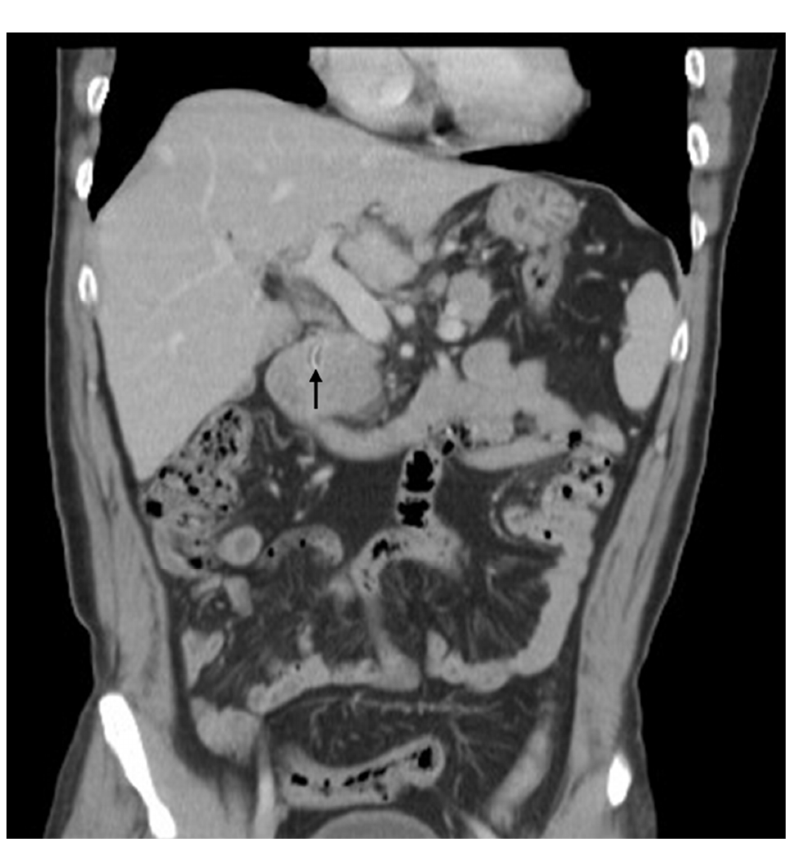
Figure 1. A computed tomography (CT) scan of the abdomen demonstrated abscess over the left lobe of the liver and a linear curve of high-density material within a mass. A 58-year-old man pre- sented at our hospital with right upper-quadrant pain and fever. He had undergone laparotomic cholecystectomy and choledochojejunostomy 28 years prior at another hospital. He had been healthy until 3 days before his admission, when his symptoms appeared. A computed tomography (CT) scan of the abdomen demonstrated abscess over the left lobe of the liver and a linear curve of high-density material within a mass (Figure 1; arrow). The patient received antibiotics and under- went aspiration of liver abscess. Endoscopic retrograde cholangiopancreatography (ERCP) was per- formed after the symptoms and signs had subsided. ERCP depicted mild dilatation of the CBD and choledojejunostomic fistula of the middle CBD. The patient underwent a biopsy forceps, which re-